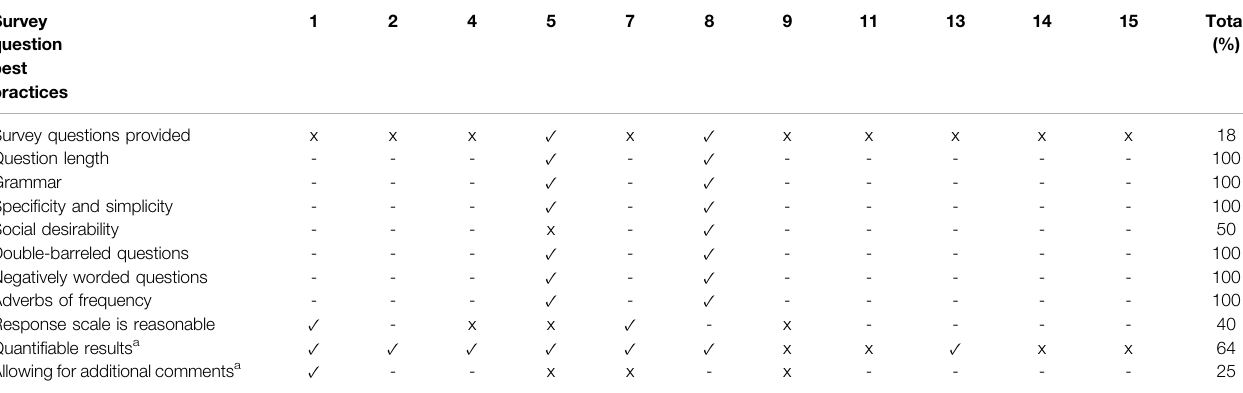
TABLE 3 | Survey science best practices connection to construction industry training